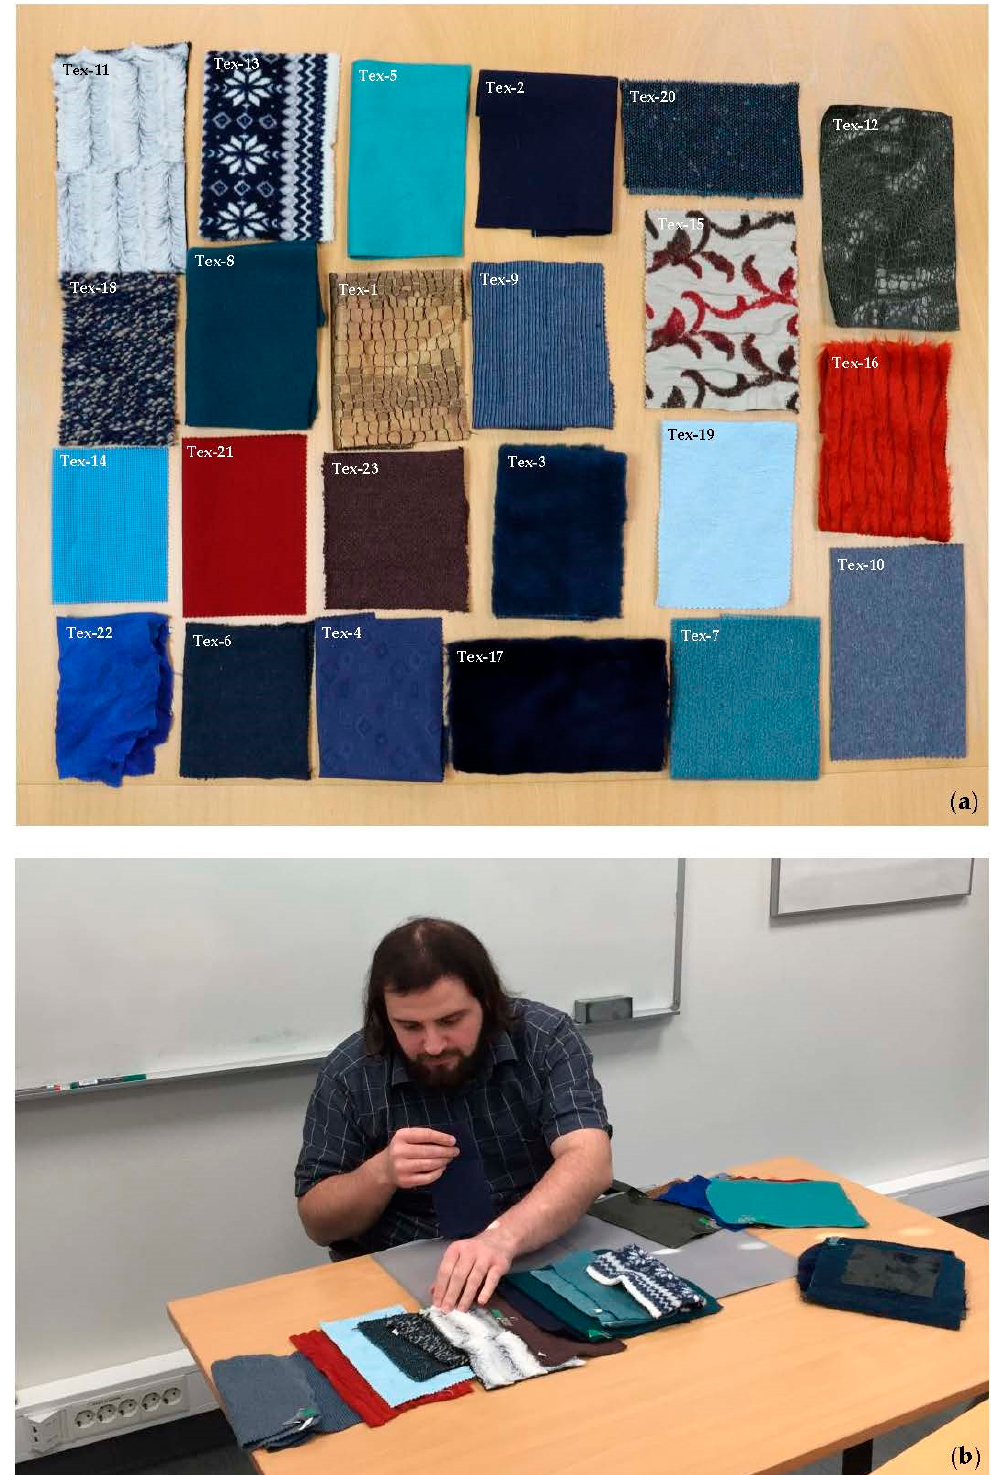
Figure 4. Twenty-three textile fabrics used in the rank ordering experiments. Although the sample sizes varied, we made sure that the samples were neither too small nor too large, and each sample enclosed all the essential texture primitives ( a ). An observer performed the rank ordering experiment, sorting the samples with respect to their perceived texture attribute. This image is reprinted from [36] with permission from IS&T ( b ). It must be noted that these photographs were taken with a DCLR camera and had undergone JPEG compression for the purpose of showcasing the physical samples versus their digital counterparts. This is why the appearance of the physical samples might